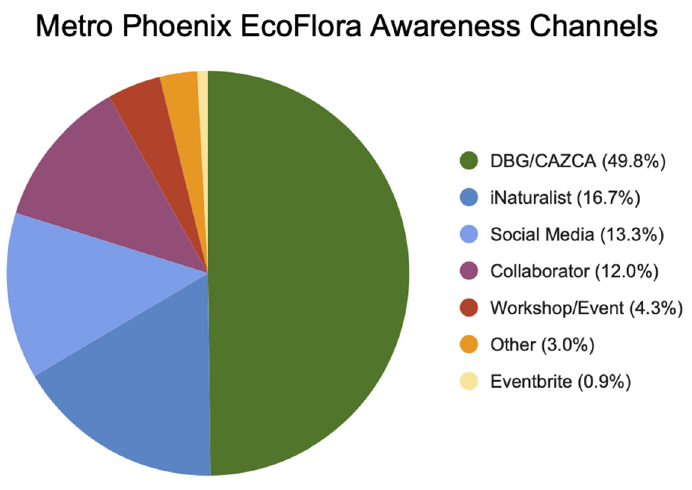
Figure 6. Channels of MPE project awareness as of 10 March 2022 according to MPE newsletter responses.